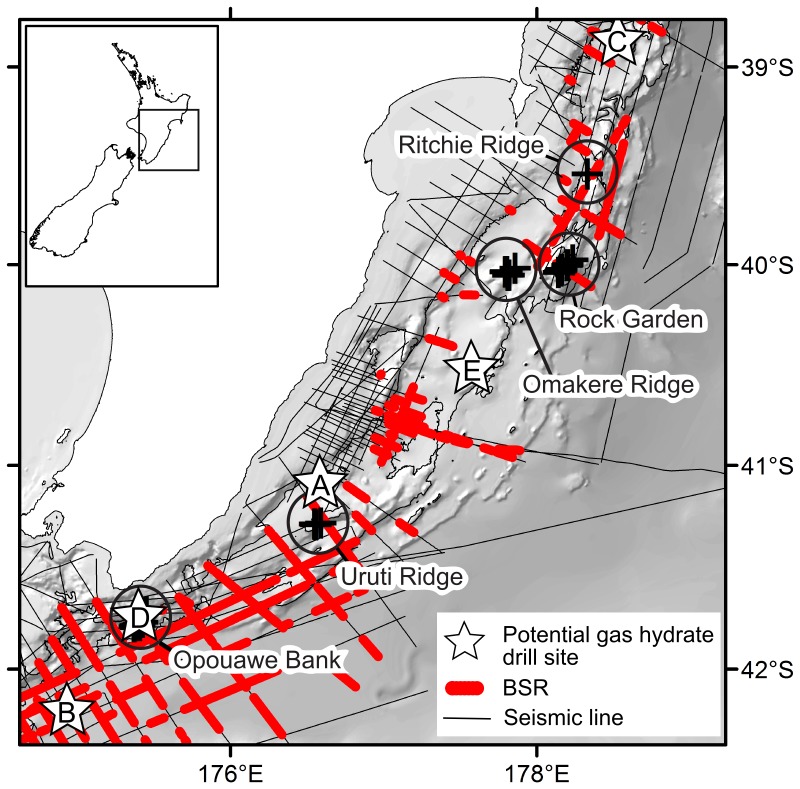
Cold seep communities and gas hydrates.Distribution of cold seep faunal communities (black crosses, regions as in Figure 1) on the Hikurangi Margin in relation to occurrence of bottom simulating reflectors (BSR) in seismic survey data and sites of potential interest for gas hydrate exploration (white stars): A, channel system north of Uruti Ridge; B, Pegasus Basin; C, Tuaheni Basin; D, Opouawe Bank; E, Porangahau Ridge.